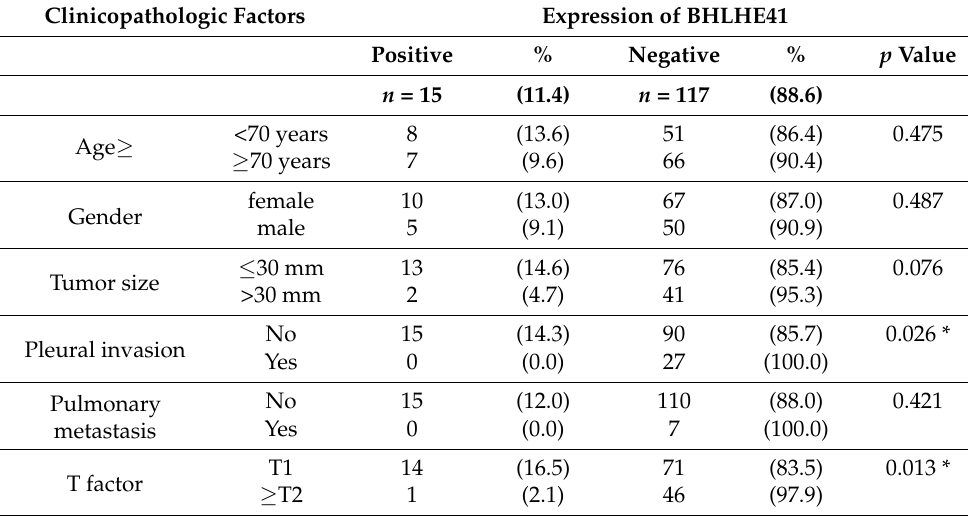
Table 2. Correlation between BHLHE41 expression and clinicopathologic factors in LUAD